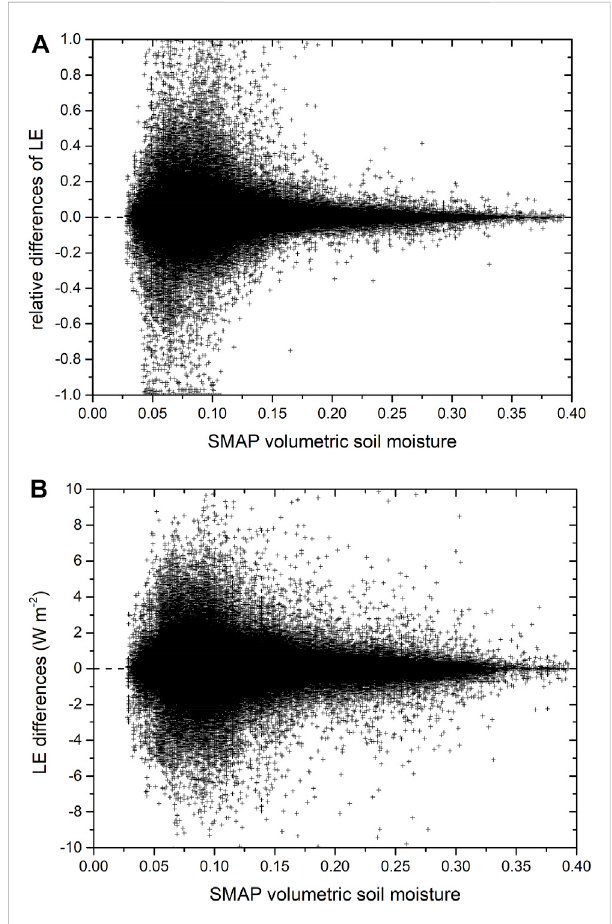
Scattered plots of the time series resulting in relative (A) and absolute (B) ETdifferencesbetweenthetwosimulationresultsandthe SMAP volumetric soil moisture.